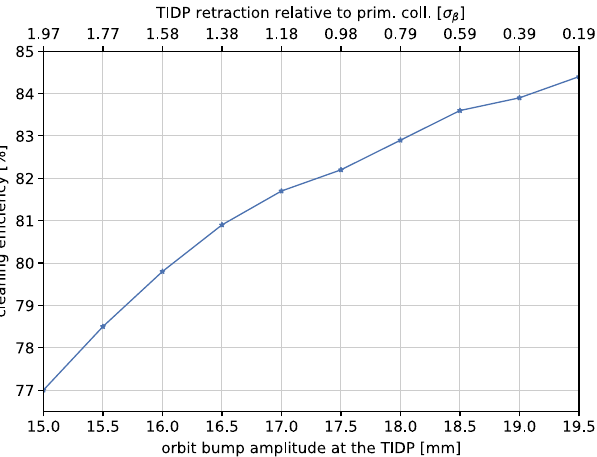
FIG. 11. Global cleaning efficiency as a function of the bump amplitude at the TIDP. Aperture model: after LS2. 17.5 mm is the baseline value of orbit bump amplitude at the TIDP (see Table